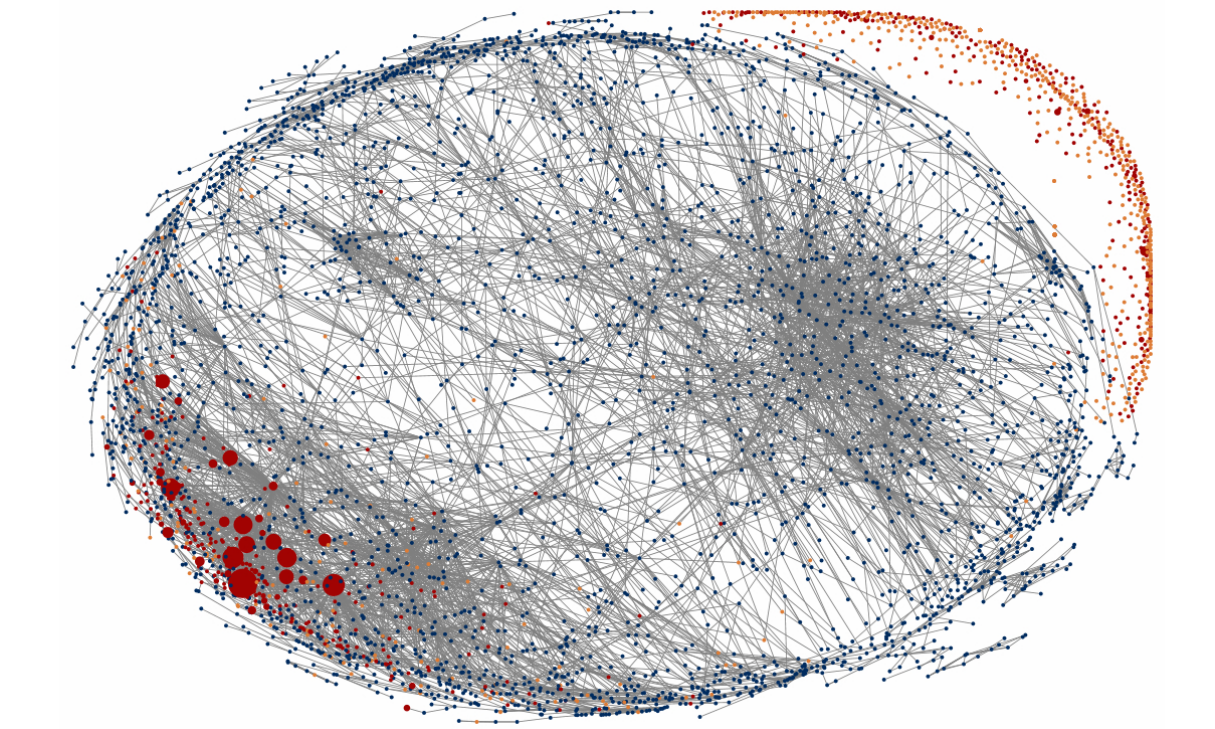
Figure 1. Friendship network of the community (red: participants who post and/or comment; orange: those who only give likes; blue: non-active members; non-active isolates